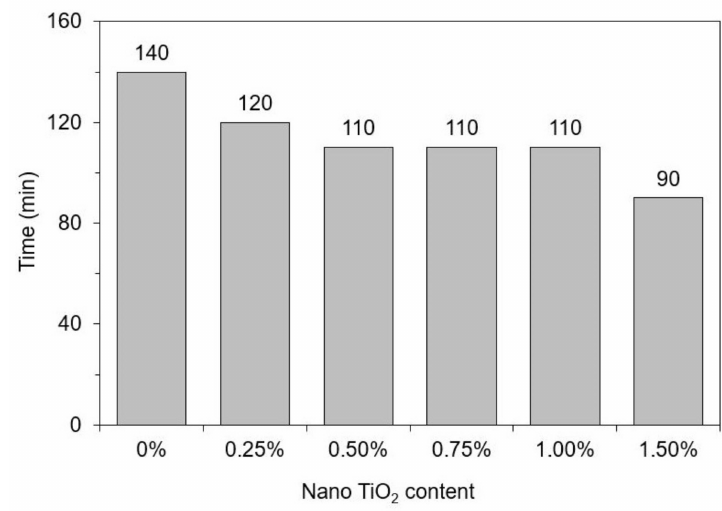
Figure 8. Printability tests results—“open time”.